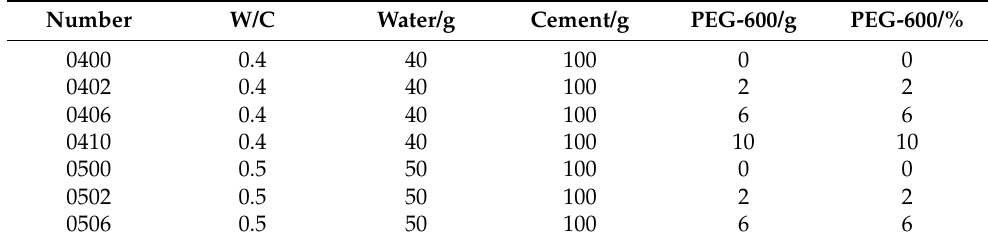
Table 6. Mix ratio of the cement paste used in the